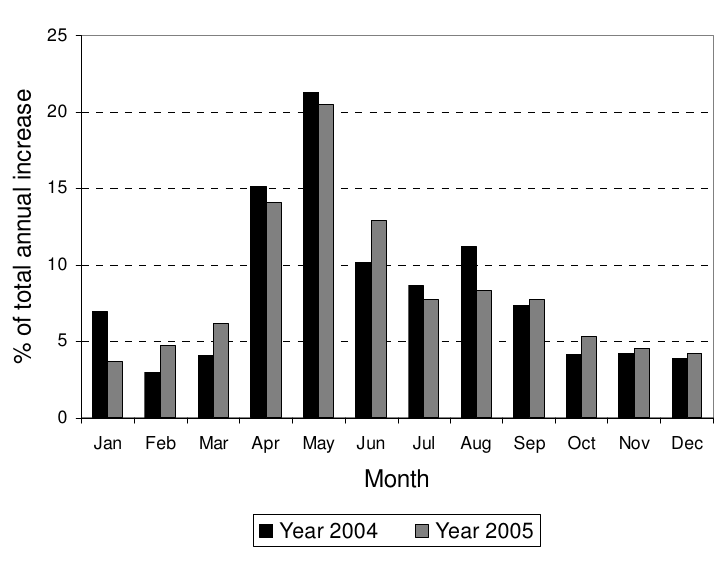
Figure 6. Summary of monthly stem growth rates over two consecutive years at Site 2 (2004–2005). Although stem enlargement occurred in every month, the